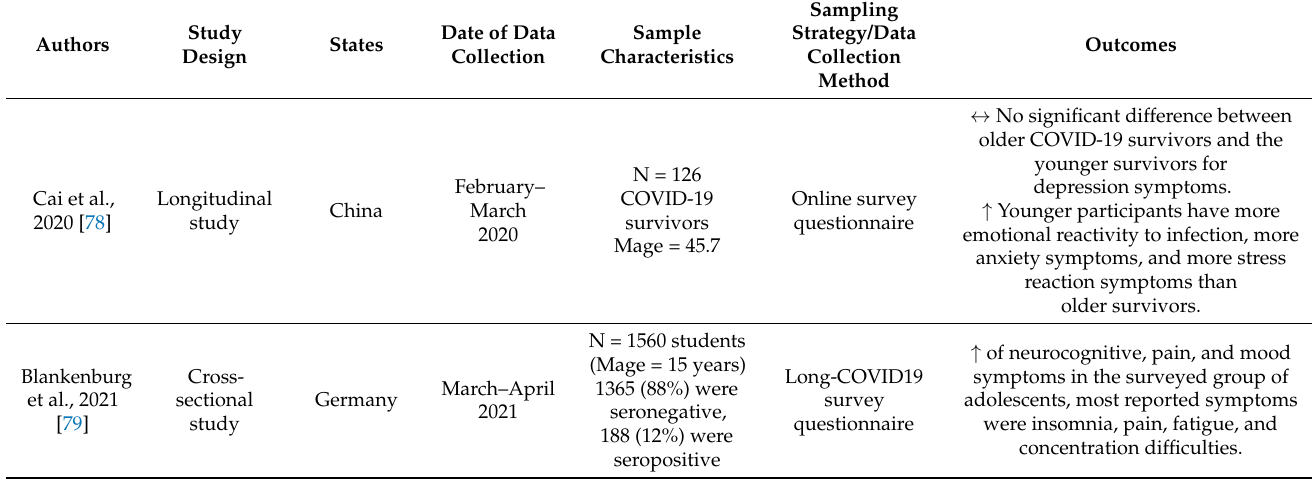
Table 1. Neuropsychiatric symptoms in the youth during and after the SARS-CoV-2